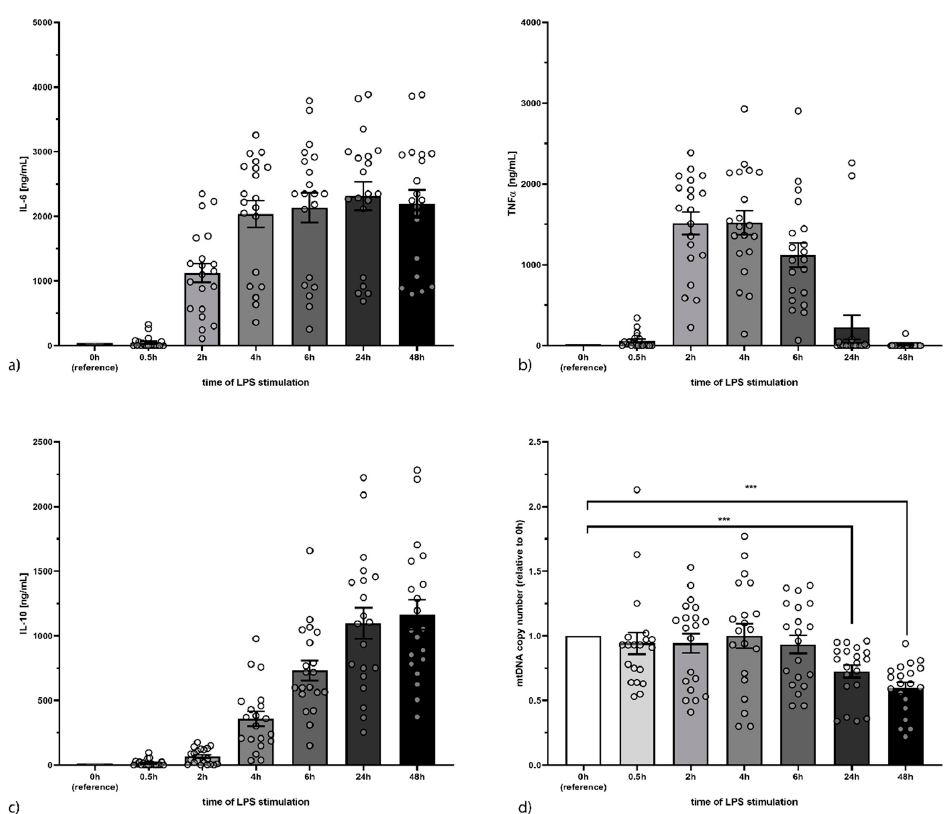
Figure 1. Secretion of IL-6 ( a ), TNF- α ( b ), and IL-10 ( c ) increased upon LPS stimulation. IL-6 and IL-10 did so in a sustained manner over 48 h while TNF- α only showed a transient activation. The mitochondrialDNAcopynumber( d )decreasedafter24hand48hofLPSstimulation(***: p <